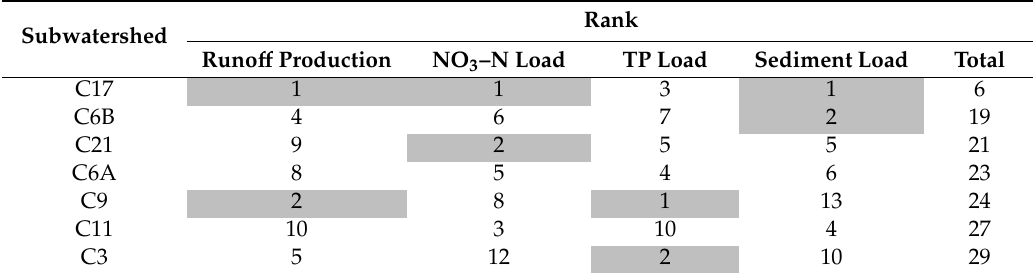
Table 5. Rankings of seven subwatersheds based on their impact on water quantity and quality in the simulated watershed. Subwatershed